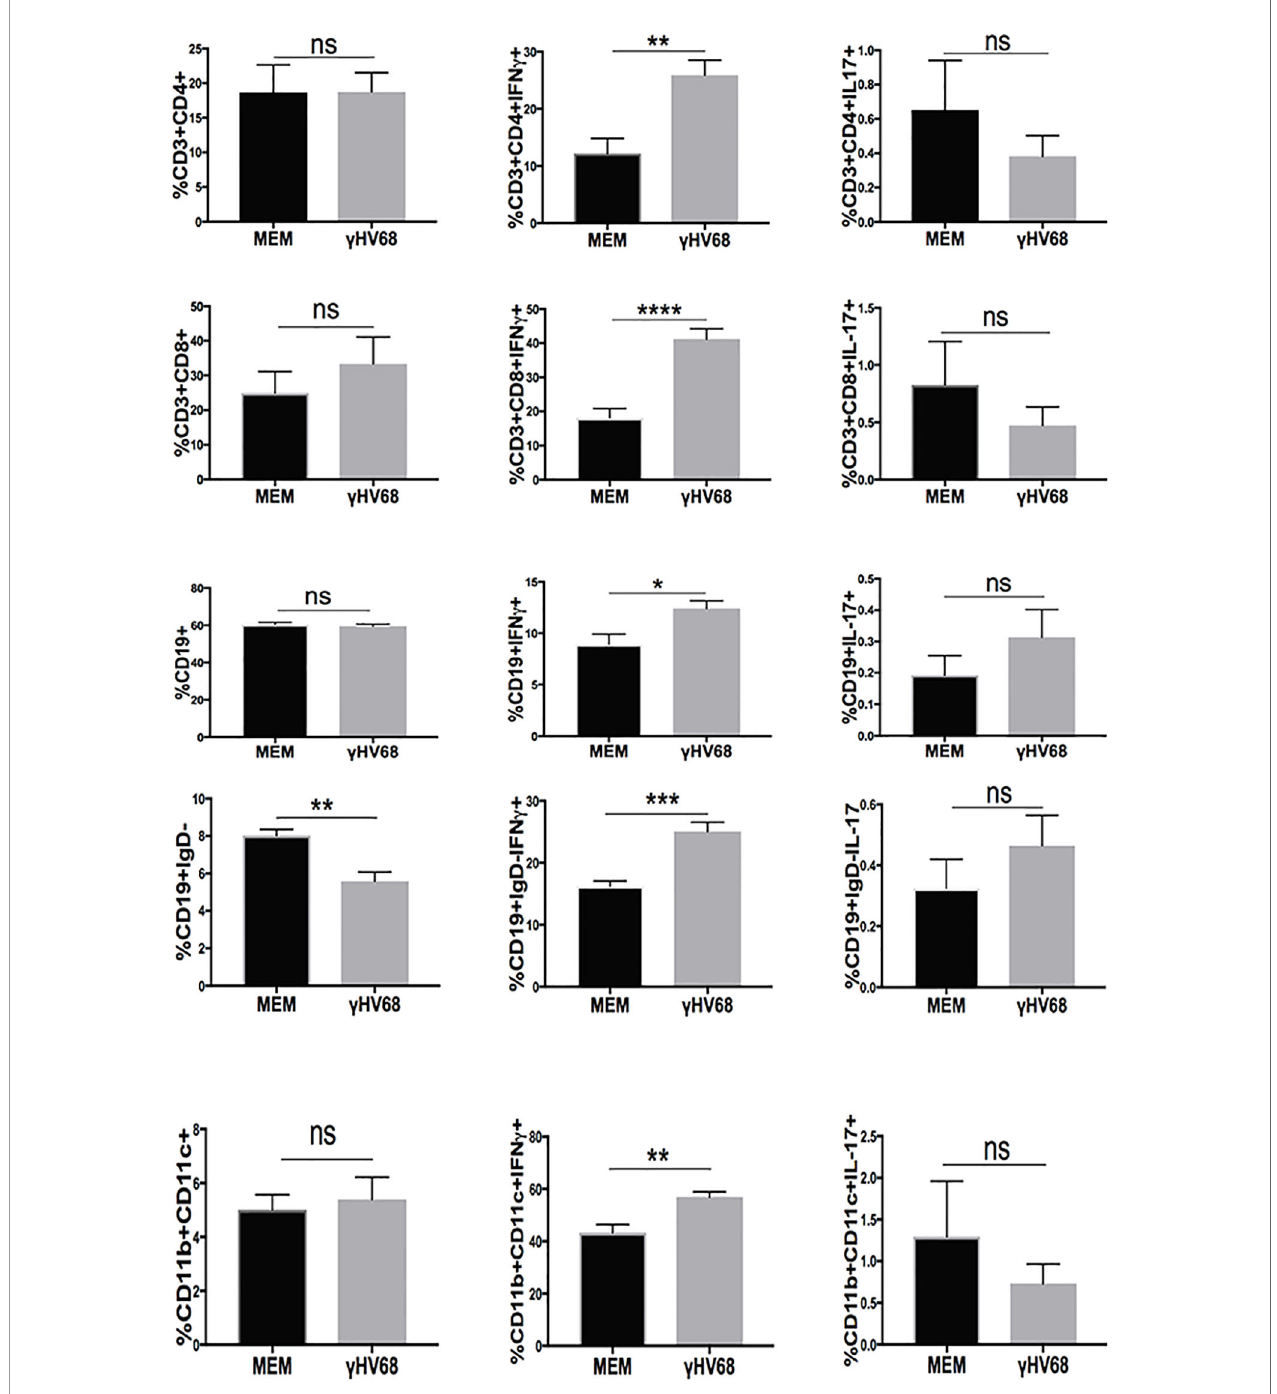
FIGURE 5 | Mice were infected with g HV-68 i.p. 5 weeks p.i. spleens were harvested, stimulated with PMA/Ionomycin and stained for IFN g and IL-17 in in CD3 + CD4 + , CD3 + CD8 + ,CD19 + , CD19 + IgD − , CD11b + CD11c + cells. Two independent experiments with 6 to 11 mice/group. Data analyzed with Student ’ s t-test: ****p < 0. 0001, ***p < 0.001, **p < 0.01, *p < 0.05. ns = not signi fi